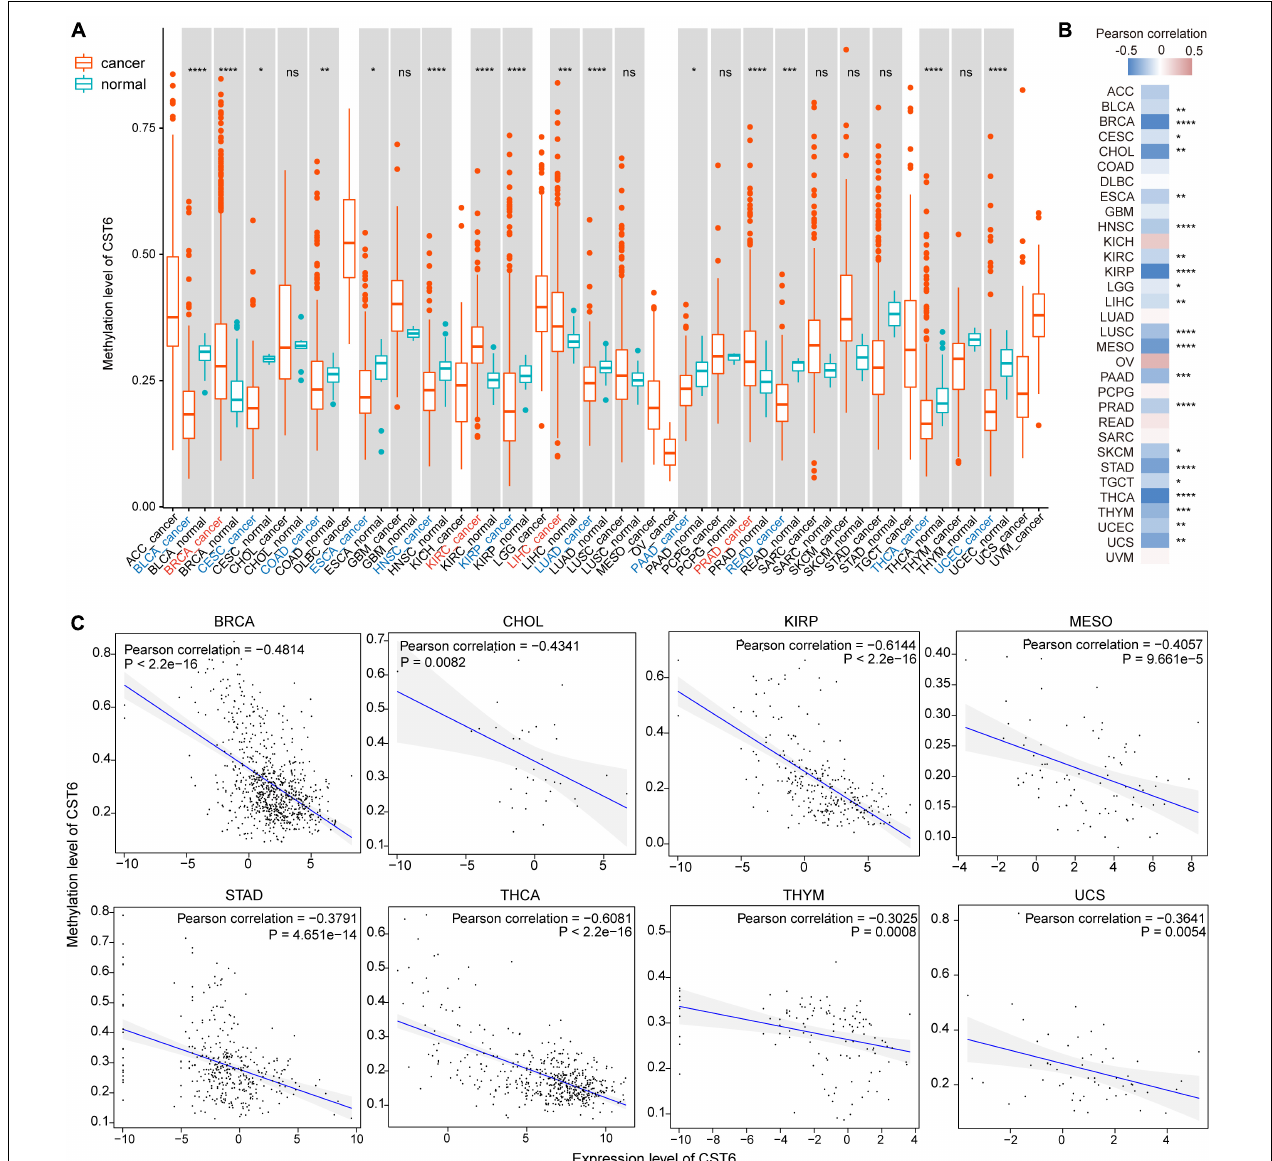
FIGURE 3 | The expression of CST6 was globally regulated by DNA methylation. (A) The DNA methylation level of CST6 in different cancer types from TCGA datasets. * p < 0.05; ** p < 0.01; *** p < 0.001; **** p < 0.0001; ns, not significant. (B) The Pearson correlation coefficients between the expression and methylation level of CST6 in TCGA cancer types. (C) The correlation between the expression and methylation level of CST6 in BRCA, CHOL, KIRP, MESO, STAD, THCA, THYM, and UCS cancer types (Pearson correlation coefficient < -0.3, p -value <